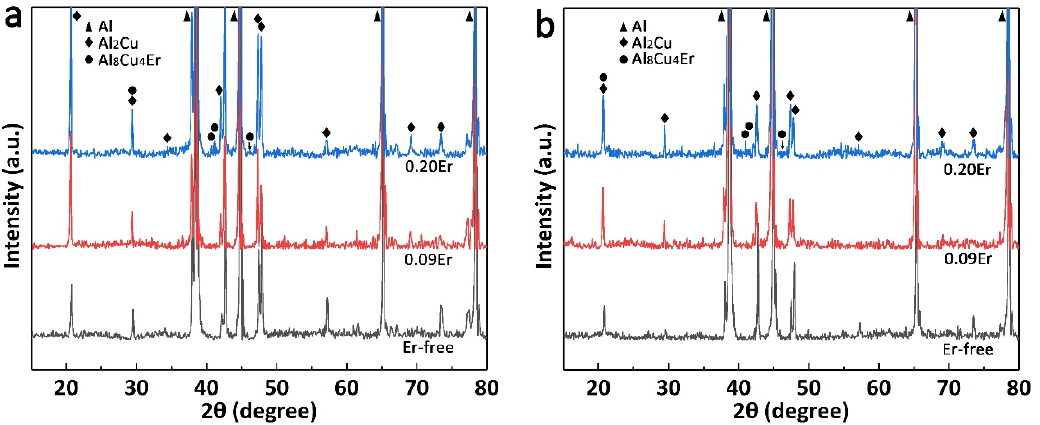
Figure 4. XRD patterns of three studied alloys of ( a ) as-cast state; ( b ) T6 state.